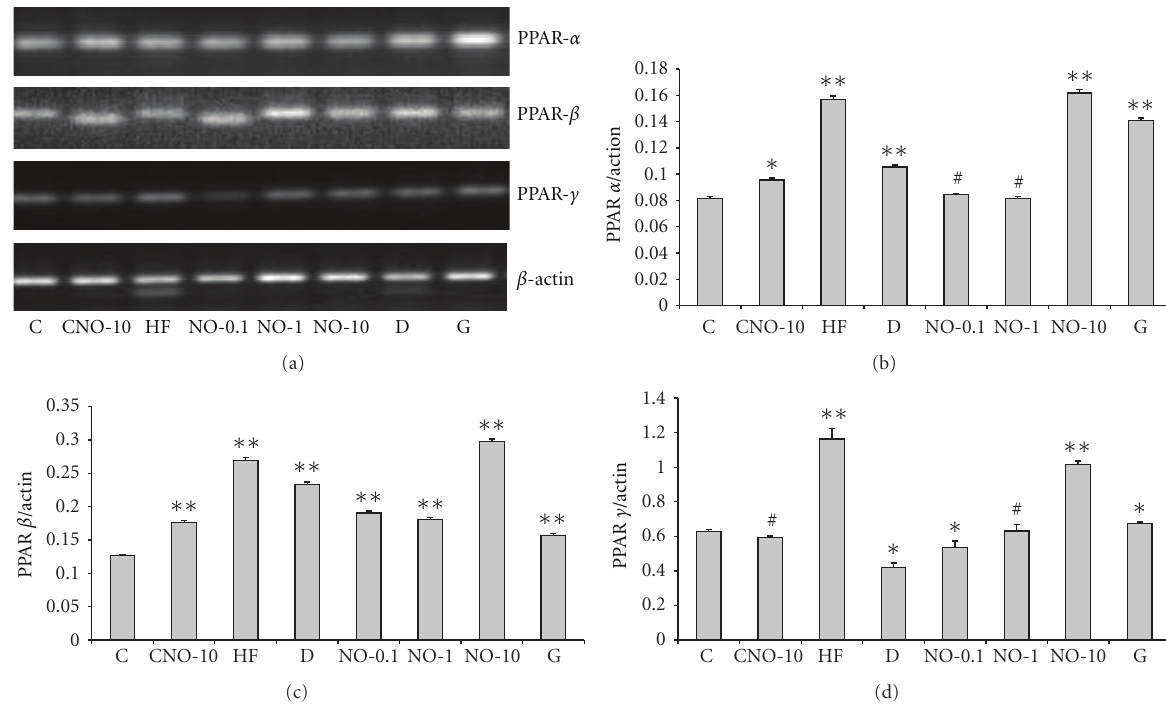
Figure 2: (a) PPAR- α , - β , - γ mRNA expressions in rat adipose tissue. (b) The ratio of PPAR- α to β -actin mRNA expressions in adipose tissue. (statistics are given as groups compared to control, ∗ P < 0 . 05, ∗∗ P < 0 . 001, # P > 0 . 05). (c) The ratio of PPAR- β to β -actin mRNA expressions in adipose tissue. (statistics are given as groups compared to control, ∗ P < 0 . 05, ∗∗ P < 0 . 001, # P > 0 . 05) (d) The ratio of PPAR- γ to β -actin mRNA expressions in adipose tissue. (Statistics are given as groups compared to control, ∗ P < 0 . 05, ∗∗ P < 0 . 001, # P > 0 . 05) C, healthy control, normal diet; CNO-10, healthy control, normal diet, and NO distillate at a dose of 375 μ g/0.5 mL of distilled water/d; HF, healthy control high fat diet; NO-0.1, type 2 diabetic, high fat diet, and NO distillate at a dose of 3.75 μ g/0.5mL of distilled water/d; NO-1, Type 2 diabetic, high fat diet, and NO distillate at a dose of 37.5 μ g/0.5 mL of distilled water/d; NO-10, type 2 diabetic, high fat diet, and NO distillate at a dose of 375 μ g/0.5 mL of distilled water/d; D, type 2 diabetic, high fat diet; G, Type 2 diabetic, high fat diet, and glibenclamide at a dose of 0.6 mg/kgbw/0.5 mL of distilled